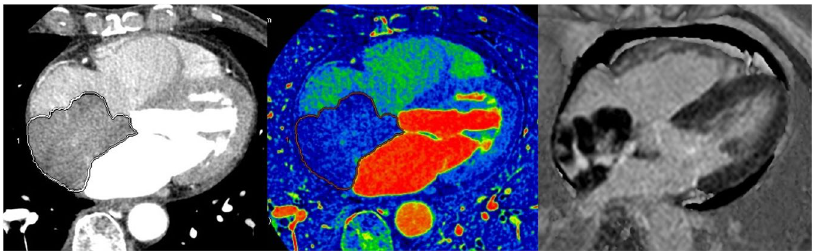
Figure 3. A 72-year-old female patient diagnosed with a lymphoma. ( A ) On enhanced CT, a 6.8 × 4.8-cm lobulated mass was observed in the right atrium. The volume of the mass was 47.1 cm 3 and the CT attenuation value of the intra-cardiac mass was 70.0 HU. ( B ) On the iodine (water) image, the iodine concentration within the VOI was 1.67 mg/ml. ( C ) MRI was performed three days later. On the LGE image, the mass shows central enhancement, the SI ratio of the mass was 4.16. Minimal pericardial effusion is